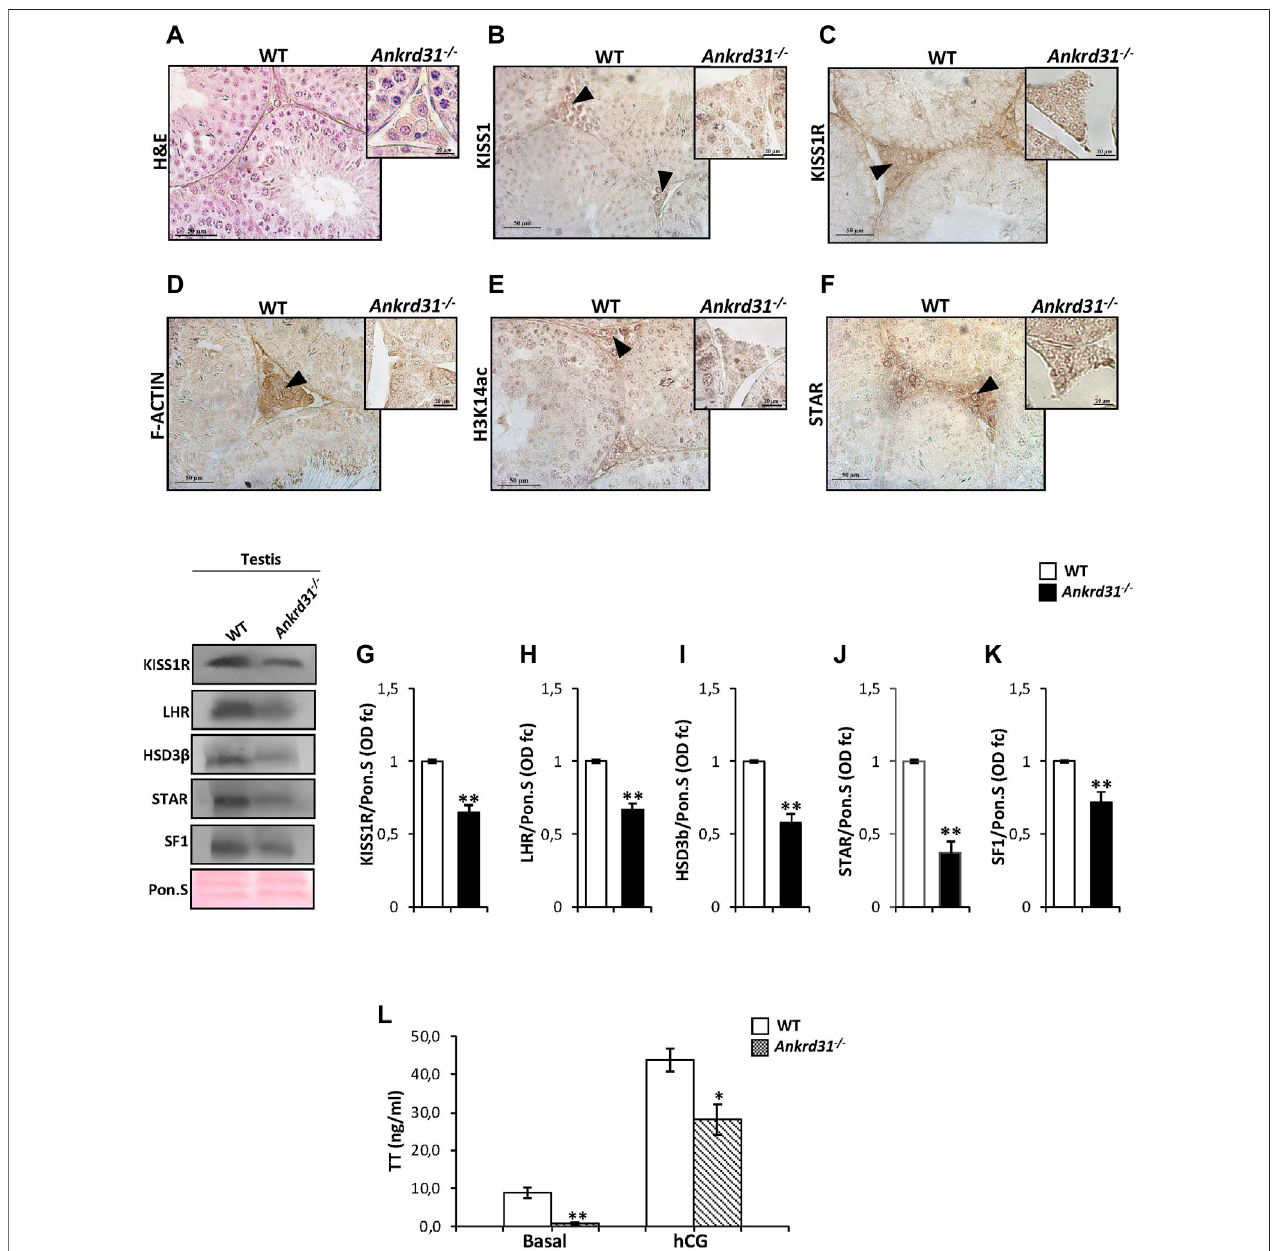
FIGURE3|(A) H&EstainingofBouin ’ s fi xedWTand Ankrd31 − / − testessections(7 μ m).Leydigcellswereindicatedbyblackarrowheads.Scalebar:50 μ m. (B – F) Immunocytochemistryof (B) KISS1, (C) KISS1R, (D) F-actin, (E) H3K14ac, (F) STARinBouin ’ s fi xedWT,and Ankrd31 − / − testessections(7 μ